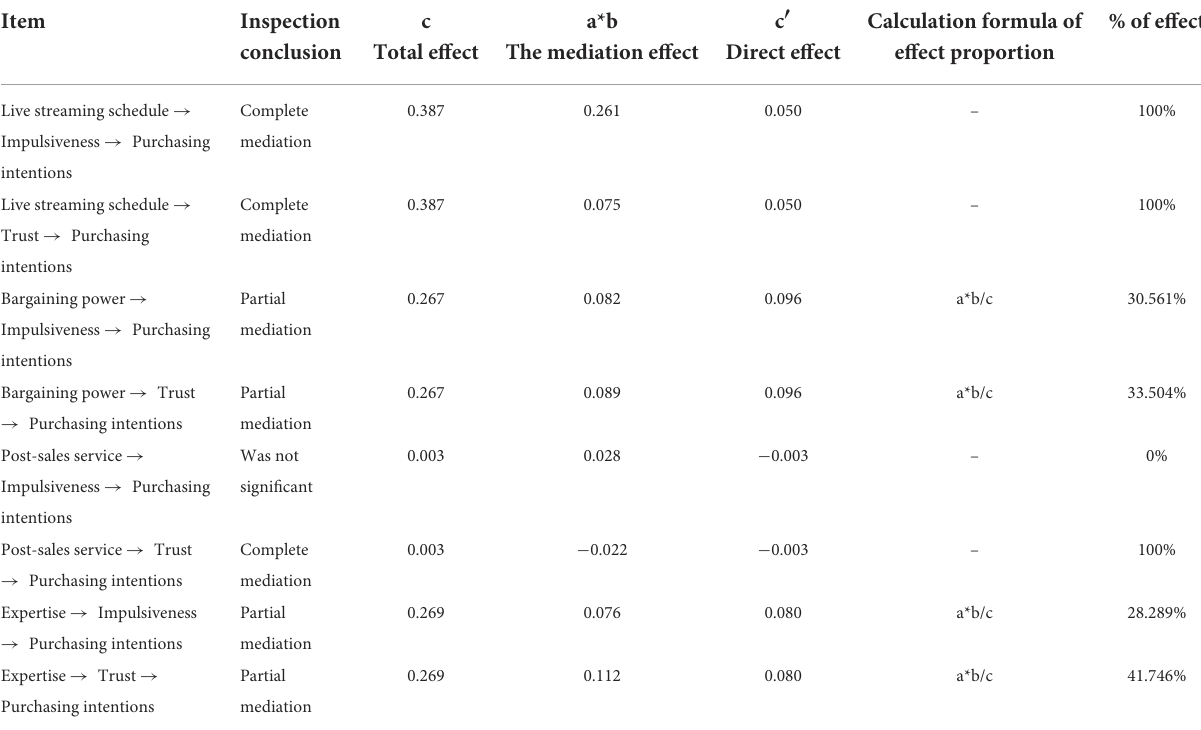
TABLE 4 Summary of mediation effect size